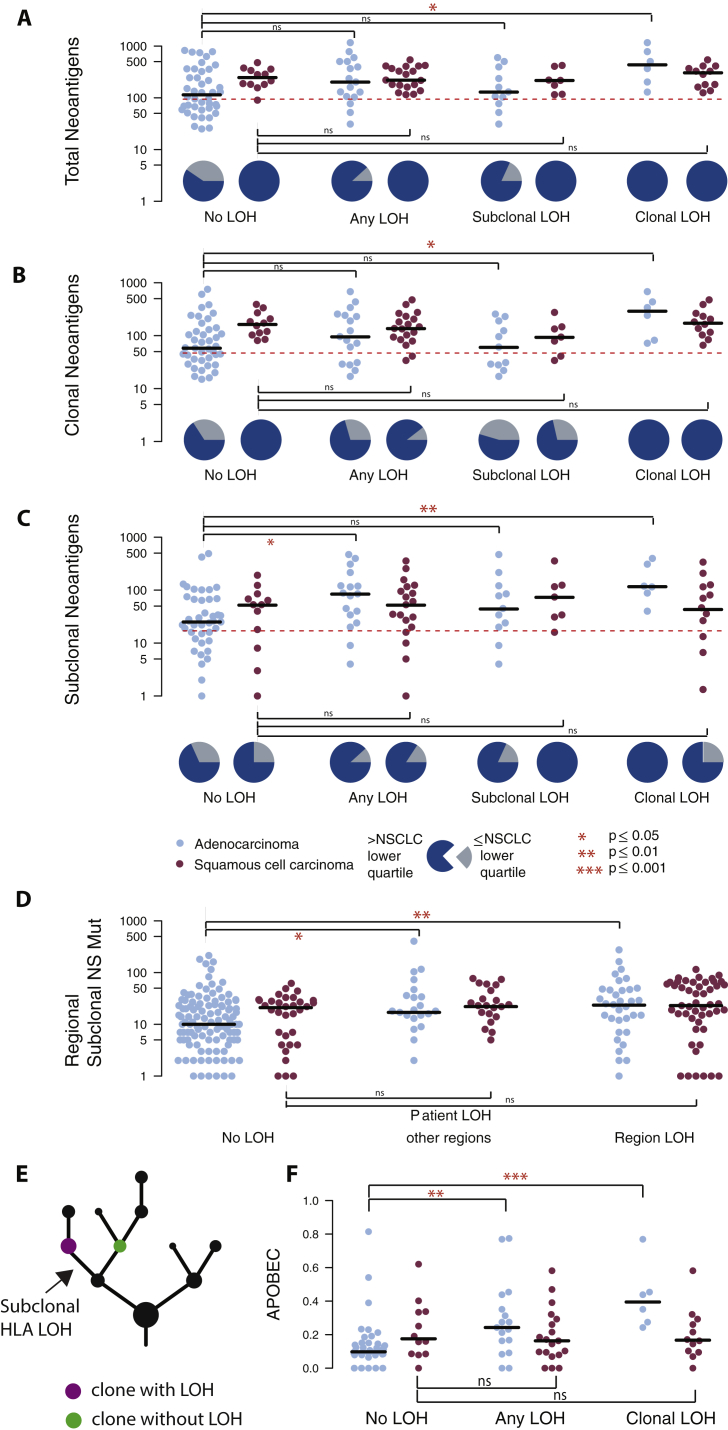
Neoantigen and Regional HLA LOH Associations, Related to Figure 4(A) The total number of neoantigens is plotted across different categories of HLA LOH for lung adenocarcinoma (light blue) and lung squamous cell carcinomas (magenta). Tumors were classified as having: no HLA LOH; any HLA LOH event, without taking into account the timing of the event; subclonal HLA LOH; or clonal HLA LOH. The lowest total neoantigen quartile is indicated by the dashed red line and the proportion of tumors with a total neoantigen burden greater or less than that is indicated by the pie charts for each HLA LOH classification group.(B) The number of clonal neoantigens is plotted across different categories of HLA LOH for lung adenocarcinoma (light blue) and lung squamous cell carcinomas (magenta).(C) The number of subclonal neoantigens is plotted across different categories of HLA LOH for lung adenocarcinoma (light blue) and lung squamous cell carcinomas (magenta).(D) The number of subclonal non-synonymous mutations is plotted for tumor regions from tumors without any indication of HLA LOH, for tumor regions without HLA LOH from a tumor with other regions harboring HLA LOH, and for tumor regions containing an HLA LOH event. All p values are calculated using an unpaired wilcoxon test.(E) Schematic of the clones considered for the comparison performed in Figure 4D. Here, the cancer subclone harboring HLA loss (purple) is shown with its sister subclone, descended from the same ancestral cancer cell, but without HLA loss (green).(F) For each lung adenocarcinoma (blue) and lung squamous cell carcinoma (purple) tumor, the relative contributions of APOBEC mutational signatures are shown. p values are calculated using an unpaired wilcoxon test.